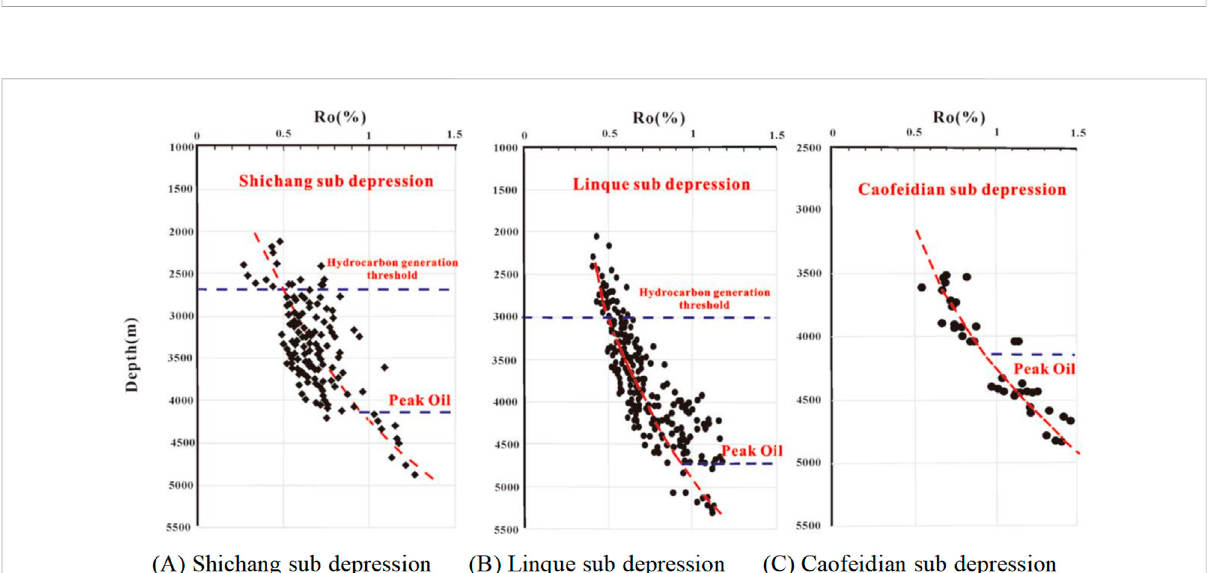
FIGURE 6 Relationship between R o and depth of Es 3 source rocks in different sub-depressions of Nanpu Sag. (A) Shichang sub depression. (B) Linque sub depression. (C) Caofeidian sub depression.